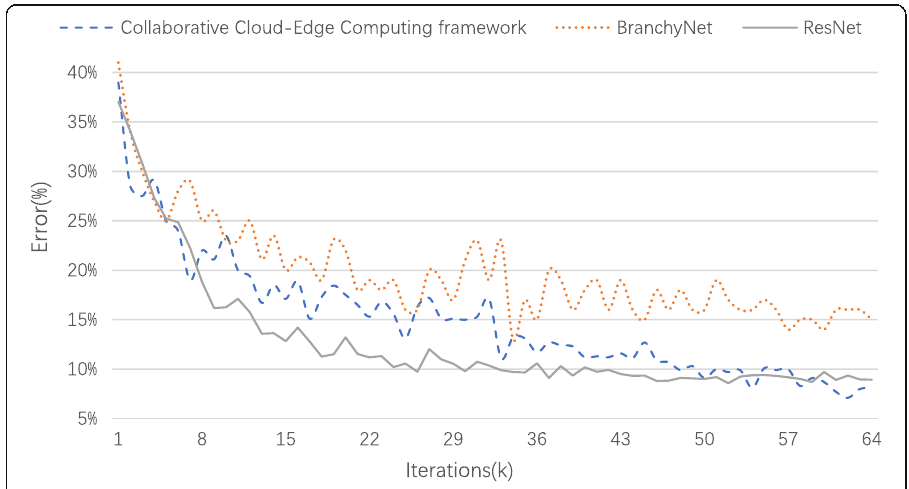
Fig. 9 Task accuracy of different frameworks. The error rate change of collaborative cloud-edge computing, BranchyNet, and ResNet framework as the number of iterations